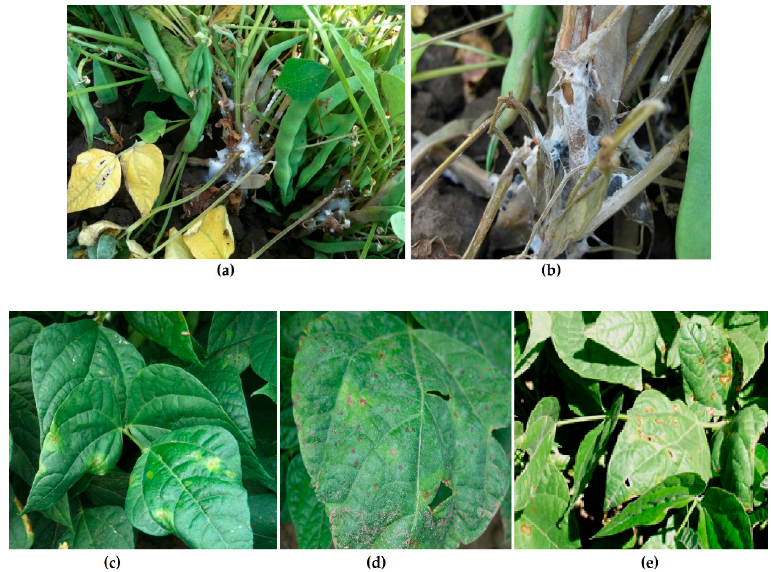
Figure 1. Disease symptoms of white mold (upper panels) and bacterial blights (lower panels). ( a ) Cottony white mycelium of S. sclerotiorum at the base of a maturing bean ( Phaseolus vulgaris L.) plant. ( b ) Networks of cottony, white mycelium, and small black sclerotia can be seen on the dead / dying bean stems and leaves. ( c ) Symptoms of halo blight caused by Pseudomonas syringae pv. phaseolicola. ( d ) Symptoms of brown spot caused by Pseudomonas syringae pv. syringae . ( e ) Symptoms of common blight caused by Xanthomonas axonopodis pv. phaseoli